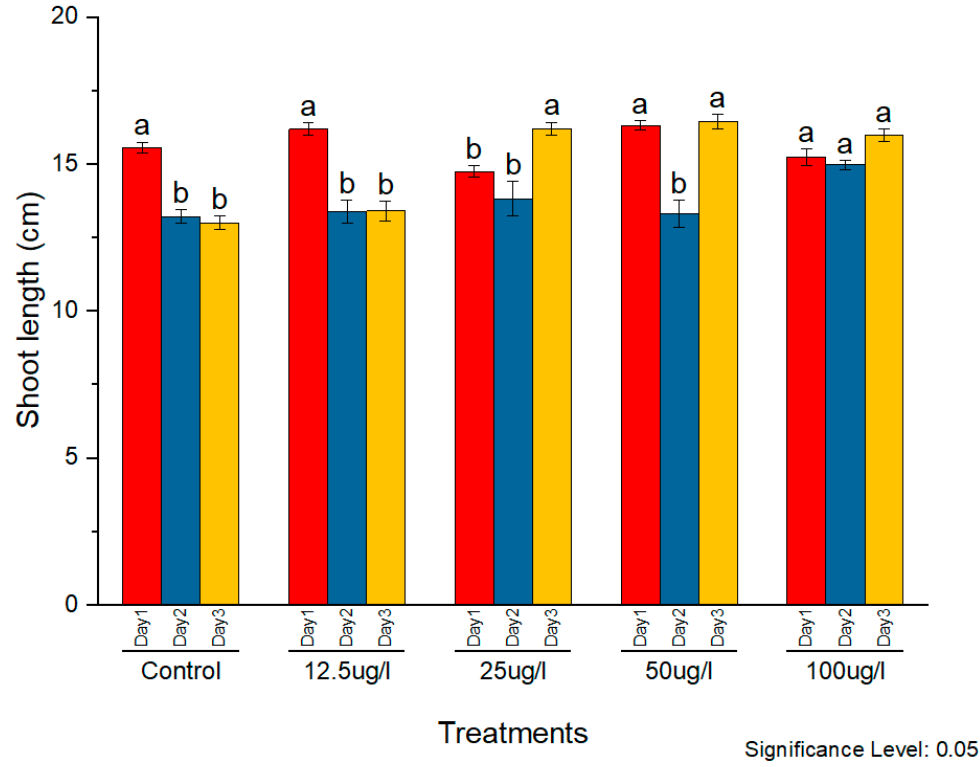
Figure 10. Phytotoxic effects of AgNPs on plant shoot, a and b indicates two significance sub groups based on Latin Square Design (LSD) value.